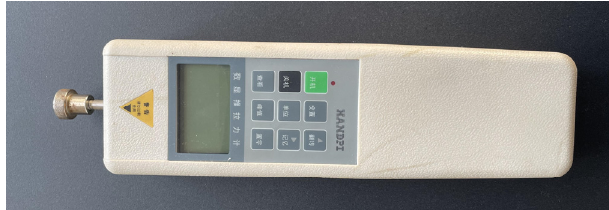
Figure 2. Photo of the digital dynamometer.